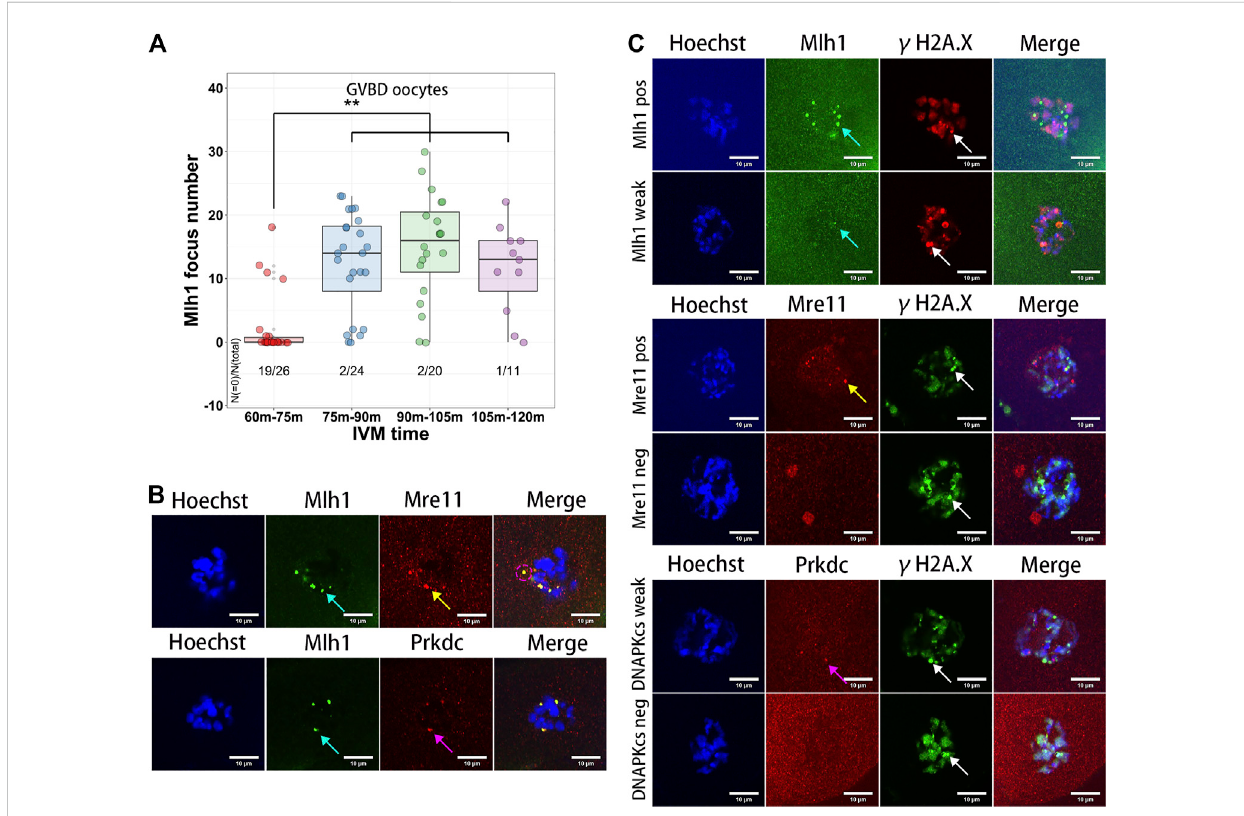
FIGURE 4 Meiosis resumption of growing oocytes released DNA repair protein foci to ooplasm. (A) Mlh1 focus number in the oocytes which have GVBD at differentIVMtime.GVBD,germinalvesiclebreakdown;IVM, invitro maturation. (B) ThefociformedbyDNArepairproteinsarereleasedtotheooplasmin the meiosis resumed oocytes (indicated by magenta dashed circle). (C) The released DNA repair protein foci are not colocalized with γ H2A.X foci in the GVBDoocytes.Mre11foci,yellowarrows;Prkdcfoci,magentaarrows;Mlh1foci,cyanarrows; γ H2A.Xfoci,whitearrows;scalebars,10 μ m.DNAare stained by Hoechst